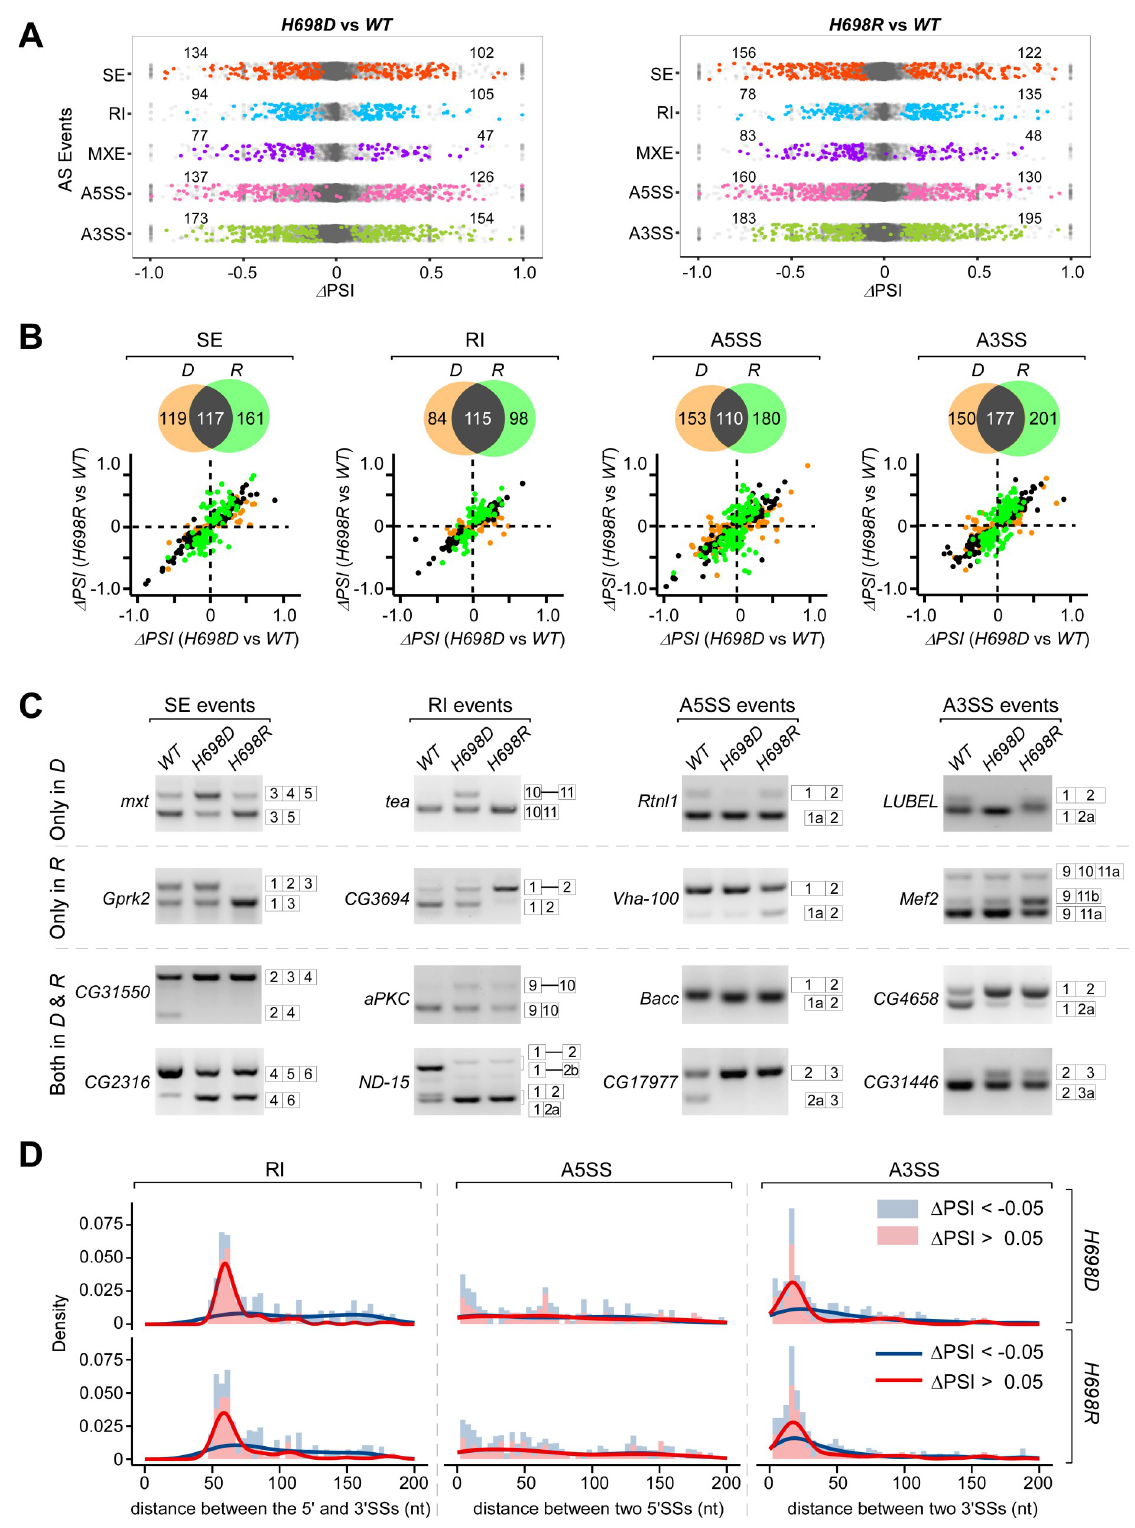
Fig 4. Alternative splicing changes in the sf3b1 mutant strains. ( A ) Scatter plots of Δ PSI of all splicing events between the two mutants and the WT , respectively. Using rMATS, AS events were analyzed in five types. Significantly changed events (| Δ PSI| > 0.05, FDR < 0.05, and with supporting reads > = 5) are shown in color dots. ( B ) Scatter plots of significantly changed AS events between the two mutants.